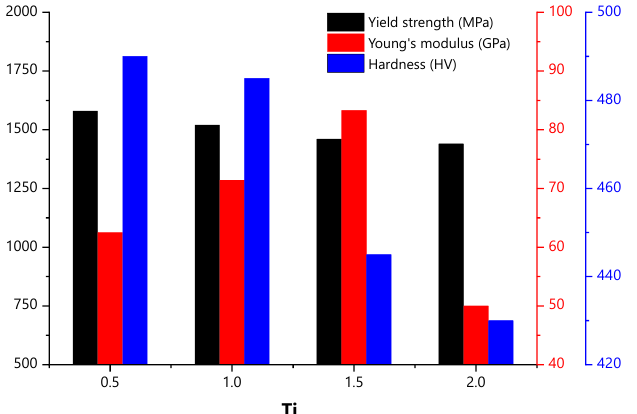
Figure 5. Evolution of yield strength, Young’s modulus, and hardness for the Ti x ZrNbTaMo alloy. Based on [20].